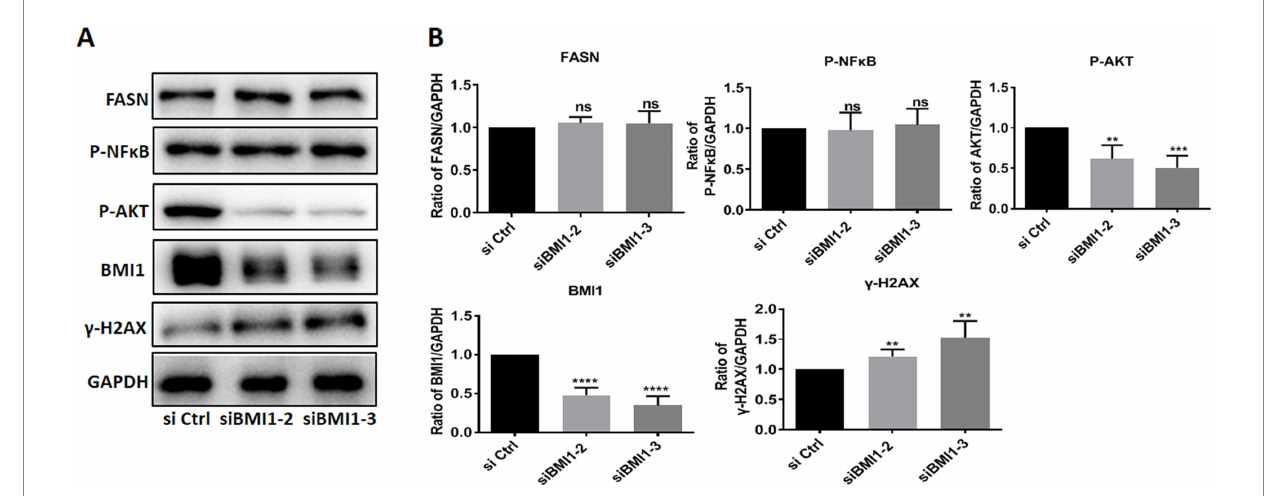
FIGURE 3 BMI1 silencing reduced the levels of phos-AKT and increased the levels of γ -H2AX in mouse SSCs.